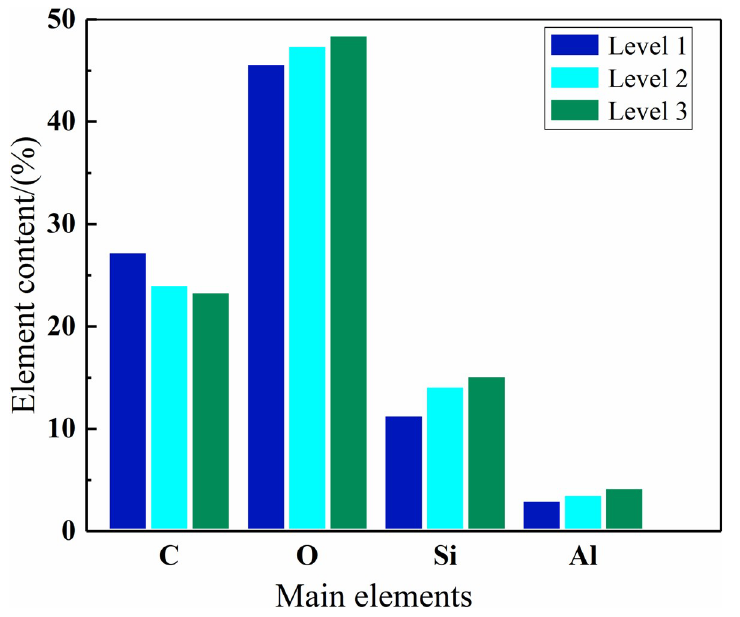
Fig 9. Element content ratio of the RTV samples at different ageing